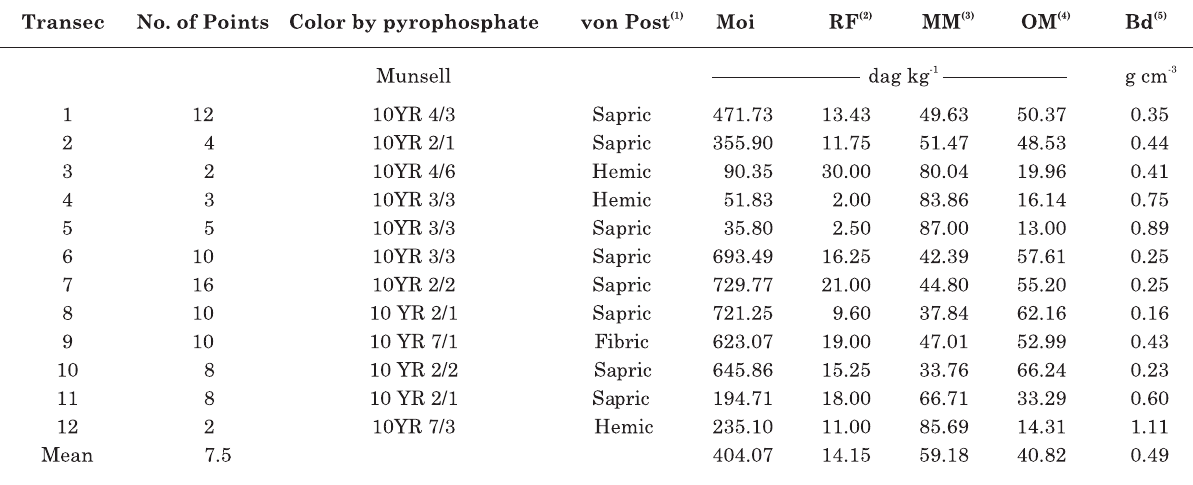
Table 2. Transects, number of sampled points, mean values of chemical and physical properties of the peatland